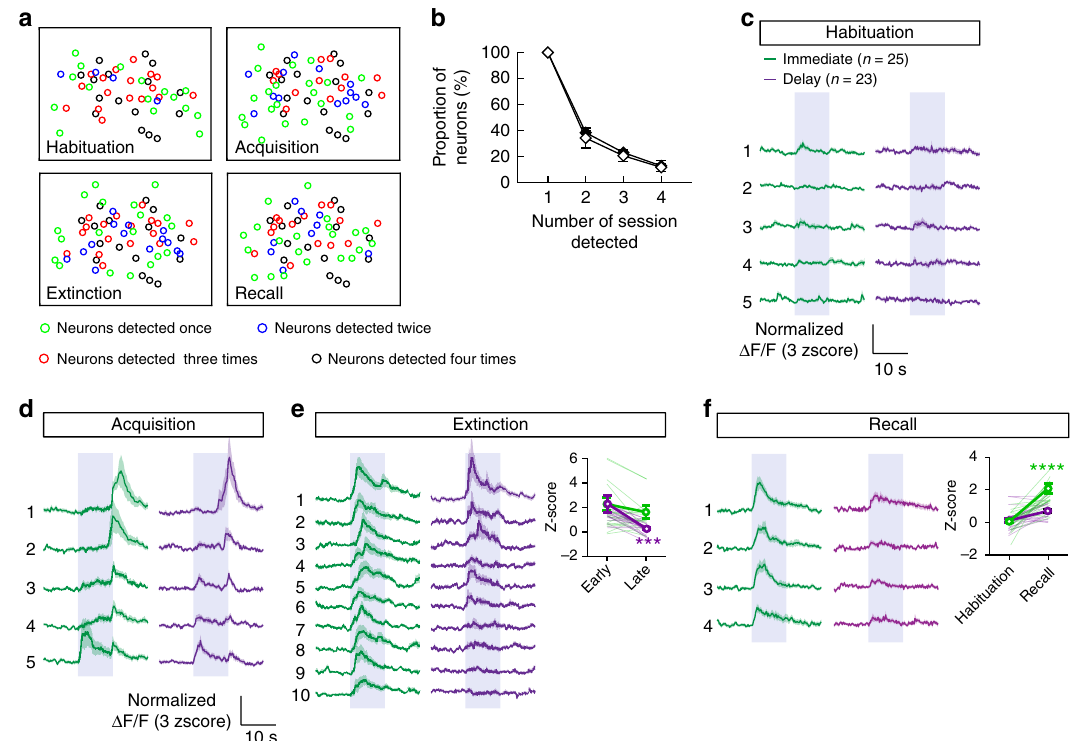
Fig. 5 Longitudinal analysis of calcium signals in CeA – CRF neurons. a Maps of active neurons that were registered as same neurons across multiple imaging sessions. b Proportion of all active neurons detected across multiple sessions for two groups of mice that underwent immediate or delay extinction training (±S.E.M.). c – f Average calcium responses (±S.E.M.) of same cells during habituation ( c ), acquisition ( d ), extinction ( e , average of 3-trial bins, inset: average Z-score responses early ( fi rst nine trials) and late (last nine trials); two-way repeated measures ANOVA, effect of time F (1,46) = 13.09, *** P = 0.0007, delay early versus delay late P < 0.001), and recall (f, inset: average Z-score responses early ( fi rst nine trials) and late (last nine trials); two-way repeated measures ANOVA, effect of time F (1,46) = 46.91, P < 0.0001, immediate habituation (hab.) versus recall, **** P < 0.0001).